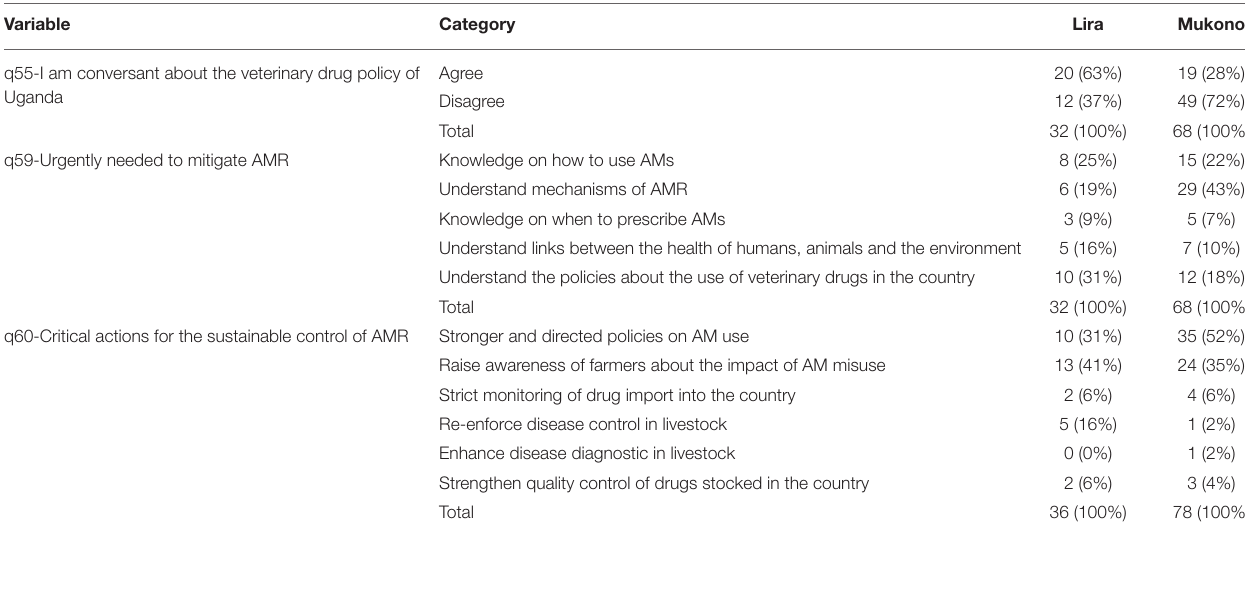
TABLE 9 | Actions needed to control AMR according to veterinary